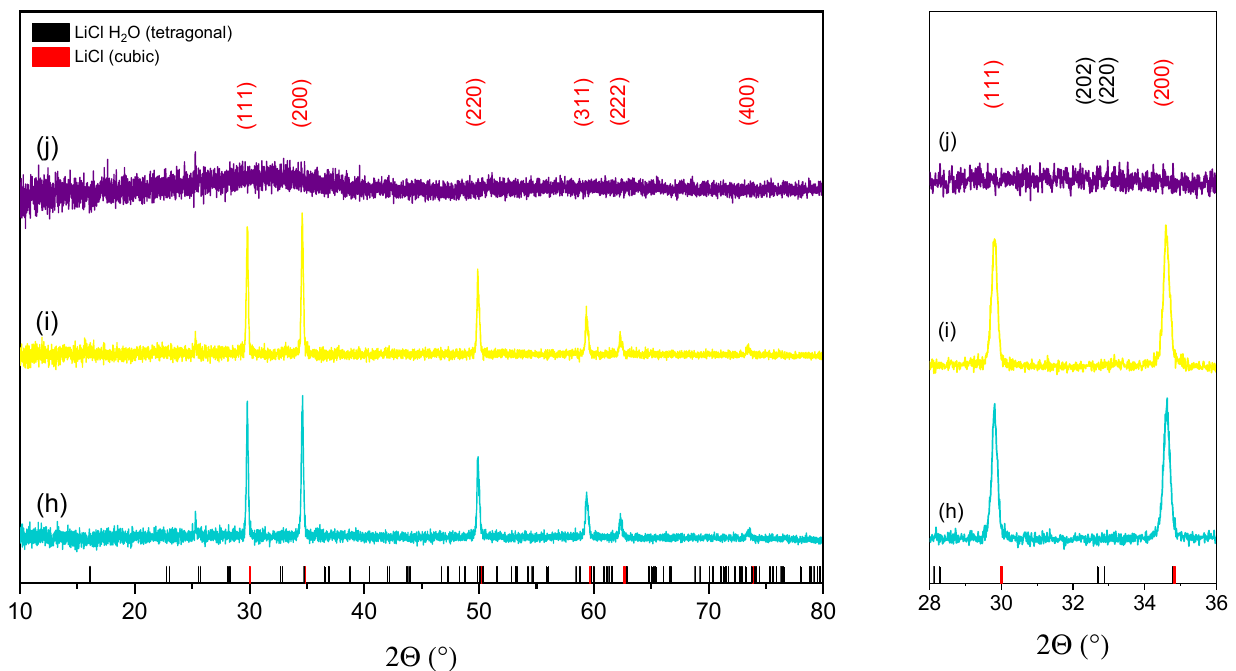
Figure 4. In situ XRD analysis of LiCl-PDMS foam under dry inert atmosphere after cooling at r.T.